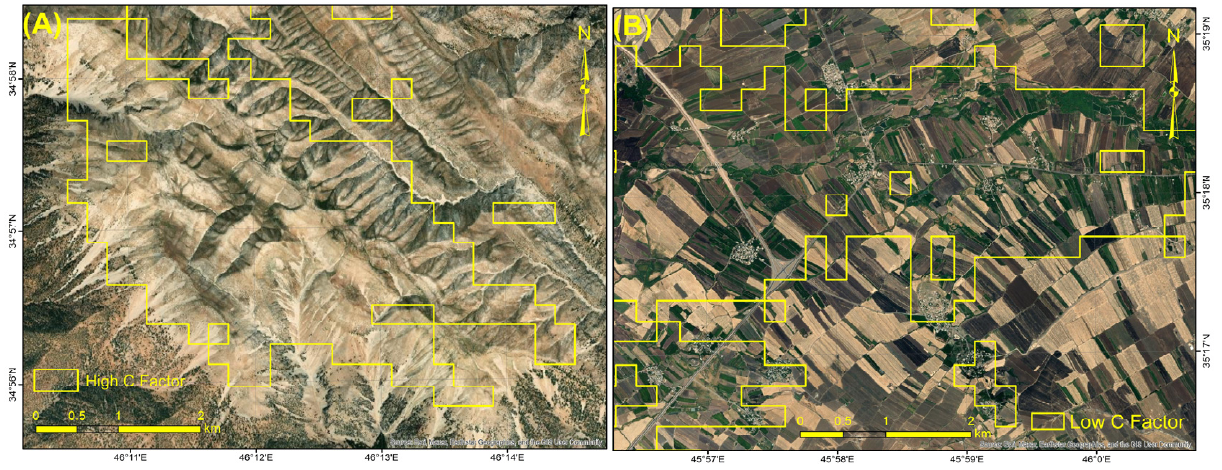
Figure 7. The very high C-factor values were distributed in the (A) landslide (B) and agricultural areas overlayed by the QuickBird image (R3:G2:B1). Table 10. C-factor parameters of the used models. C Factor